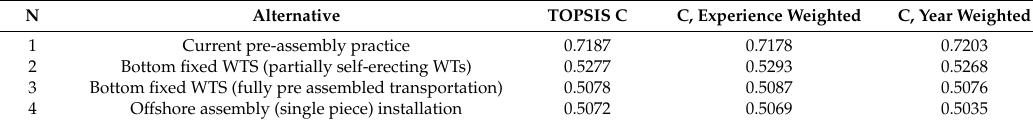
Table 9. First stage TOPSIS results for ‘Assembly